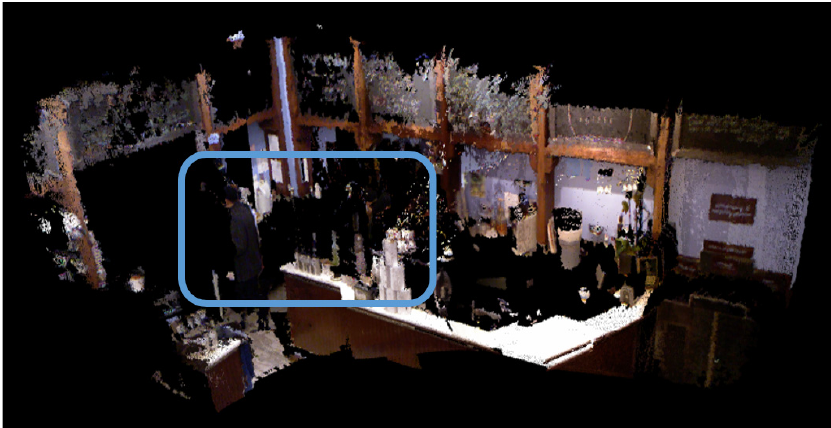
Figure 10. Dense point cloud map constructed by our